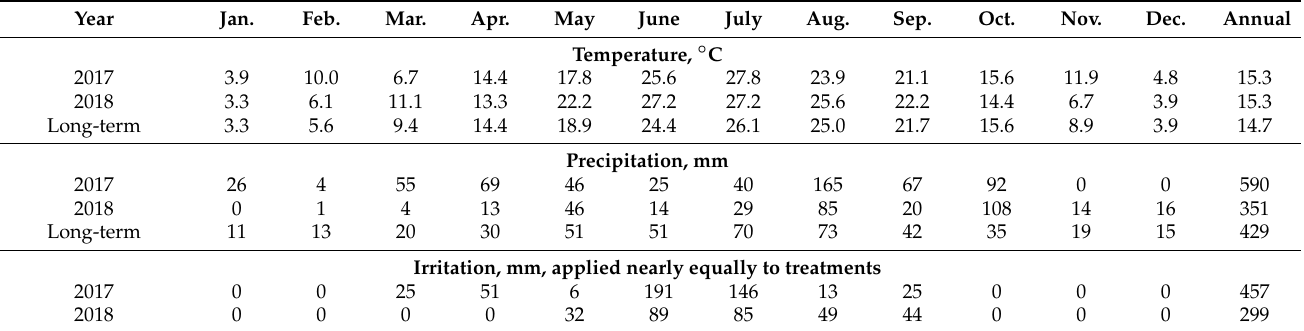
Figure 1. Map of the study site at Tucumcari, NM, USA, with irrigation water source strip plots identified. Table 1. Monthly mean air temperatures and total precipitation and irrigation amounts at Tucumcari, NM, USA, during the study period in which alfalfa was planted on 18 August 2017 and sampled in late October of 2017 and 2018, and the long-term temperature means and precipitation totals